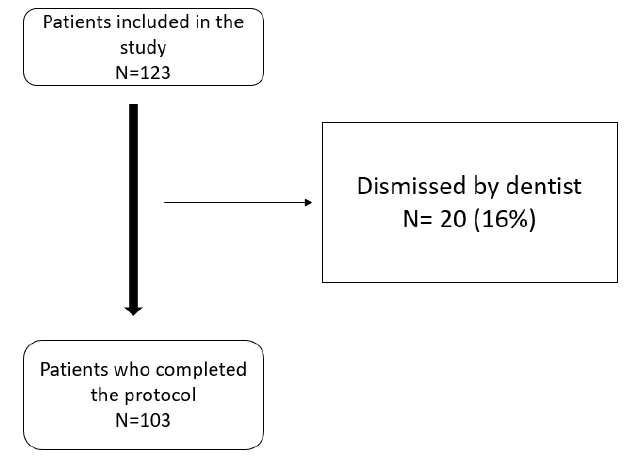
Figure 3. Patient flow chart. The average age of the patients was 46.3 years, the majority were male (89.3%), and approximately 30% were smokers. The average body mass index was 28.6 kg/m 2 and torus was detected in 34 patients (33%). Table 2a presents the primary characteristics of the 103 patients. Table 2b shows the characteristics according to the presence or absence of torus, finding no differences between the two groups. Table 2. ( a ) Characteristics of the 103 patients. ( b ) Characteristics of the patients depending on whether torus is present or not.